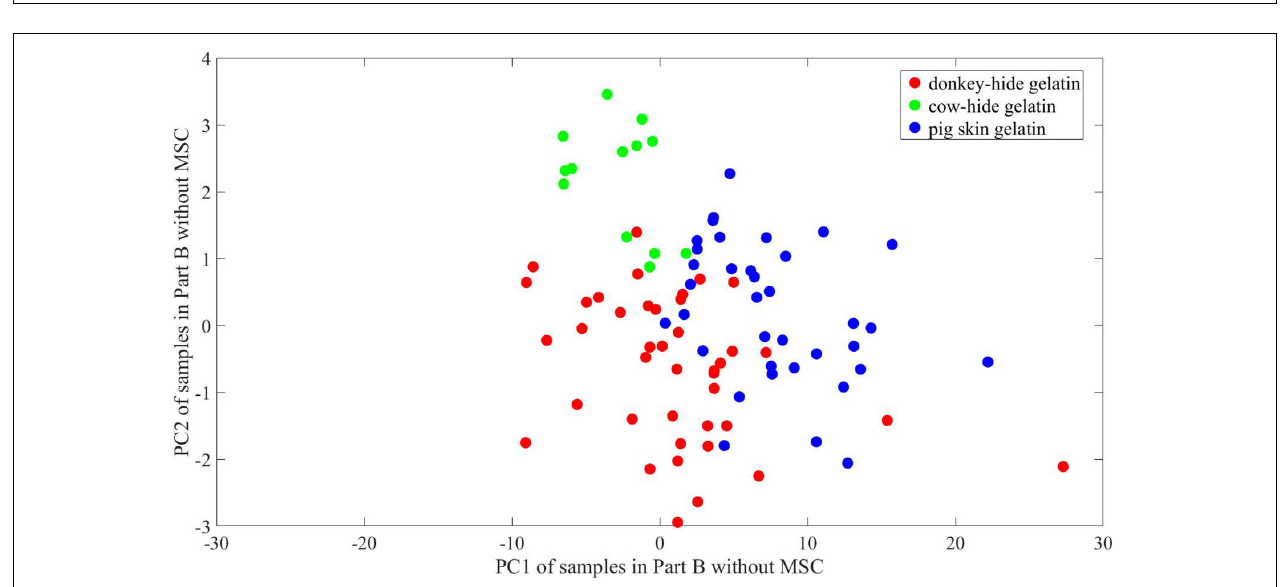
FIGURE 10 | 2-D PCA of samples in Part B without